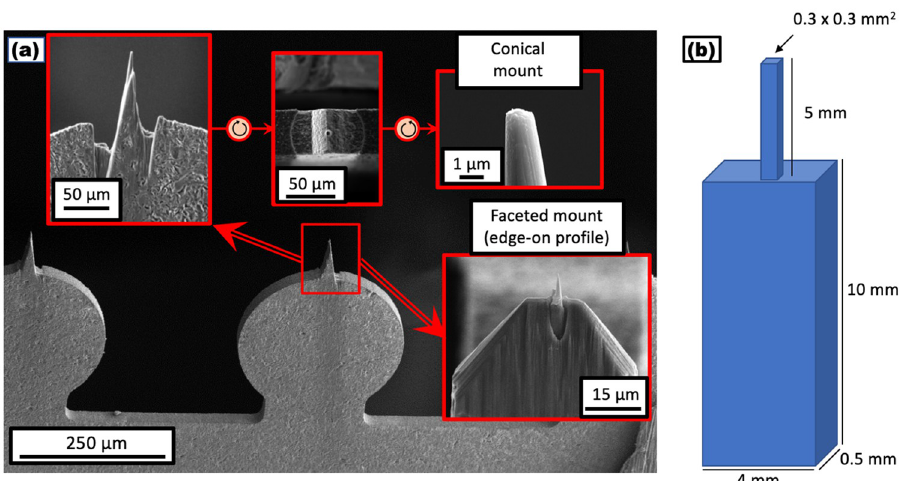
Fig 4. Pre-milling of sample mountings (a) SEM images showing the preparatory focused ion beam milling upon a SS304 Reacthub grid (300- μ m target version), demonstrating two mounting preparations–a simple conical mounting format and a more elaborate faceted mounting; (b) Schematic of “candle” geometry fashioned by electrical discharge machining for bulk specimens.